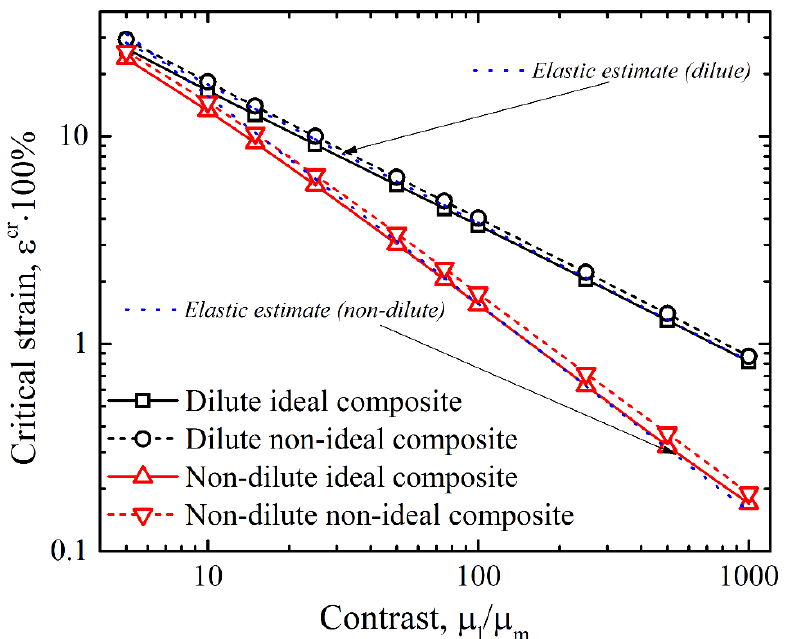
Figure 4. The dependencies of critical strain on the contrast in ideal layered composites with v l = 0.025 (continuous black) and v l = 0.2 (continuous red) and non-ideal composites with v l = 0.025 and f = 0.5 (dashed black) and v l = 0.2 and f = 0.5 (dashed red). Dotted blue curves correspond to the elastic estimates [1,27].